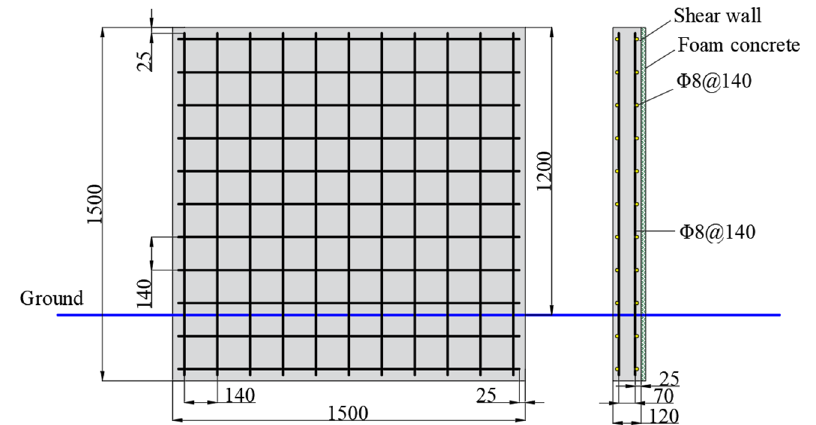
Figure 6. Structural dimension and reinforcement mode of the RC wall (unit: mm).